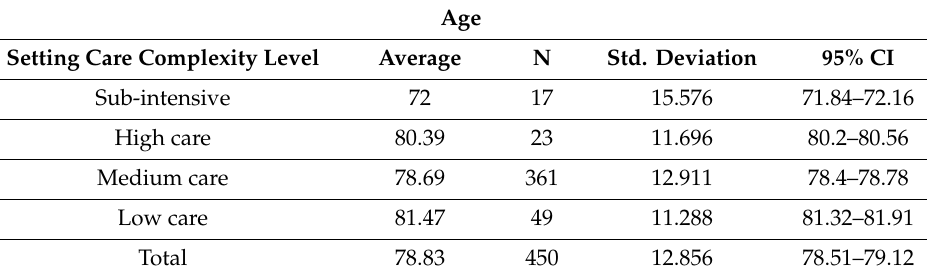
Table 4. Average age by setting.